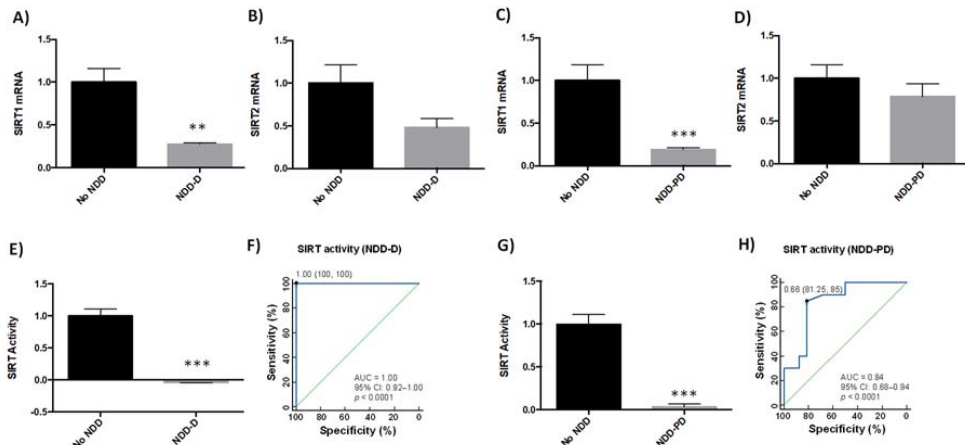
Figure 2. SIRT expression and activity in buffy coat samples from healthy individuals and patients with NDDs. qPCR was performed in samples from patients from the no-NDD ( n = 9), NDD-D ( n = 6) and NDD-PD ( n = 9) groups with TaqMan probes for SIRT1 ( A , C ) and SIRT2 ( B , D ); unpaired t test (** p < 0.01; *** p < 0.001). SIRT activity was measured colorimetrically using buffy coat samples from healthy subjects ( n = 15), patients with NDD-D ( n = 16) ( E ), and in patients with NDD-PD ( n = 19). ( F ) ROC curve analysis of SIRT activity; the AUC for SIRT in patients with dementia was 1 (95% CI: 0.92–1.00), p < 0.0001. The optimal cutoff value determined by the Youden’s index was 1.00 (specificity: 100%, sensitivity: 100%) (black filled circle). The diagonal green line is the ROC curve reference line. ( G ) SIRT activity levels in patients with parkinsonisms; unpaired t tests (*** p < 0.001). Data are presented as the mean ± S.E.M. ( H ) The AUC for SIRT from ROC curves for patients from the NDD-PD group was 0.84 (95% CI: 0.68–0.94), p < 0.0001. The optimal cutoff value according to the Youden’s index was 0.66 (specificity: 81.25%, sensitivity: 85%) (black filled circle). AUC, area under the curve; CI, confidence interval; no-NDD, individuals with no neurodegenerative diseases; NDD-D, NDD patients with dementia; NDD-PD, patients with parkinsonisms representing PD and PD-like disorders; PD, Parkinson’s disease; qPCR, quantitative real-time PCR; ROC 5, receiver operating characteristic 5; SIRT,